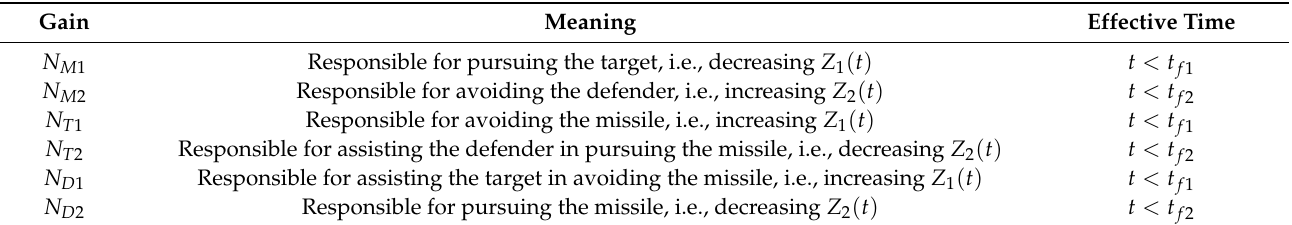
Table 1. Meanings of the effective navigation